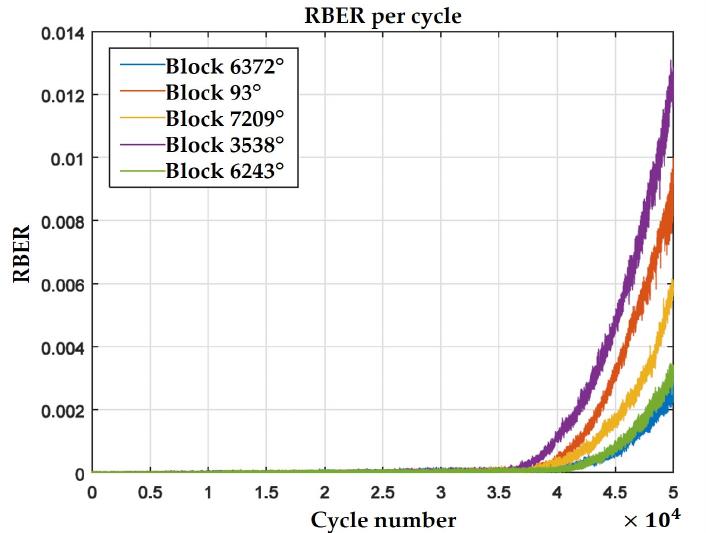
Figure 5. The NAND flash chip degradation shows that the write/erase cycles increase the raw bit error rate (RBER). This graph is for a NAND flash Micron 29F256G08CJABB with a capacity of 32 GB. The type of input to store is